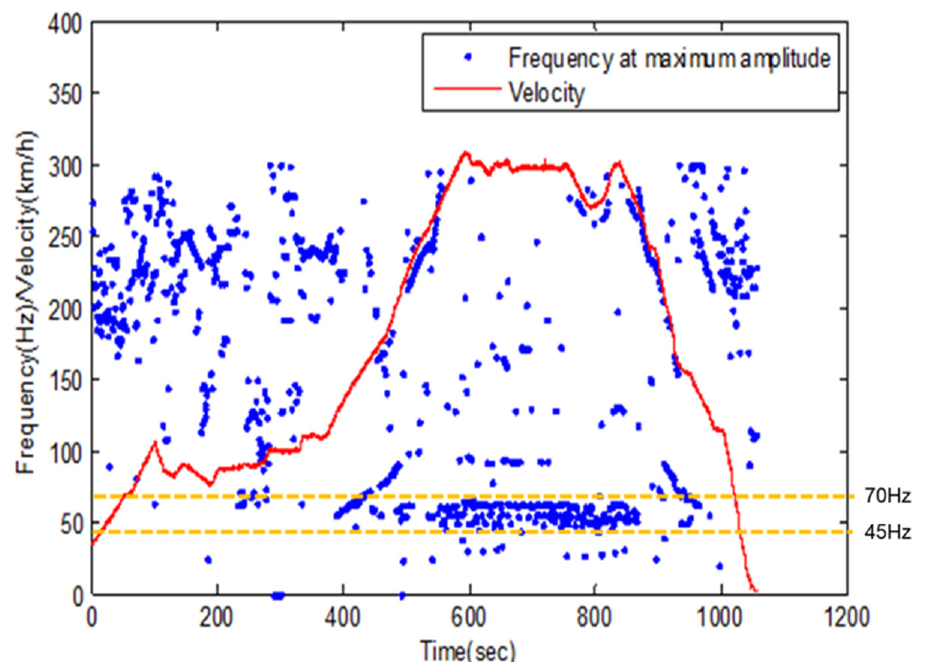
Figure 12. FFT results and velocity data. The resonance frequency occurred mainly in the frequency band between 45 and 70 Hz at 300 km/h, and the resonance frequency varied according to the train’s velocity.